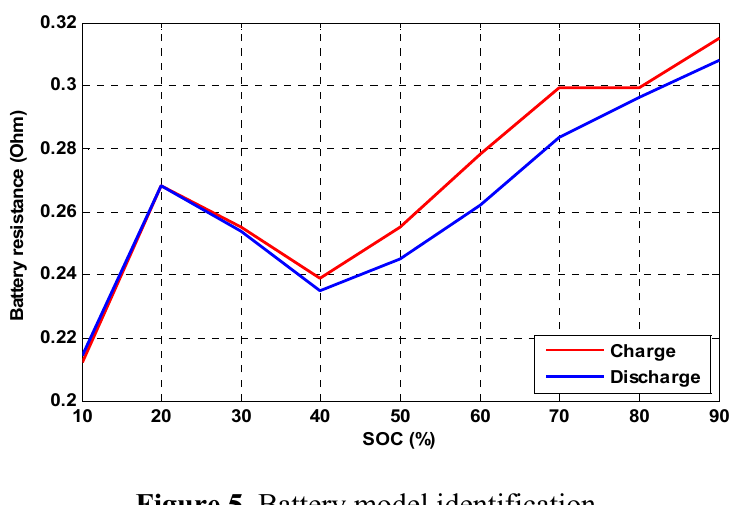
Figure 4. Curve of Battery resistance vs. SOC.